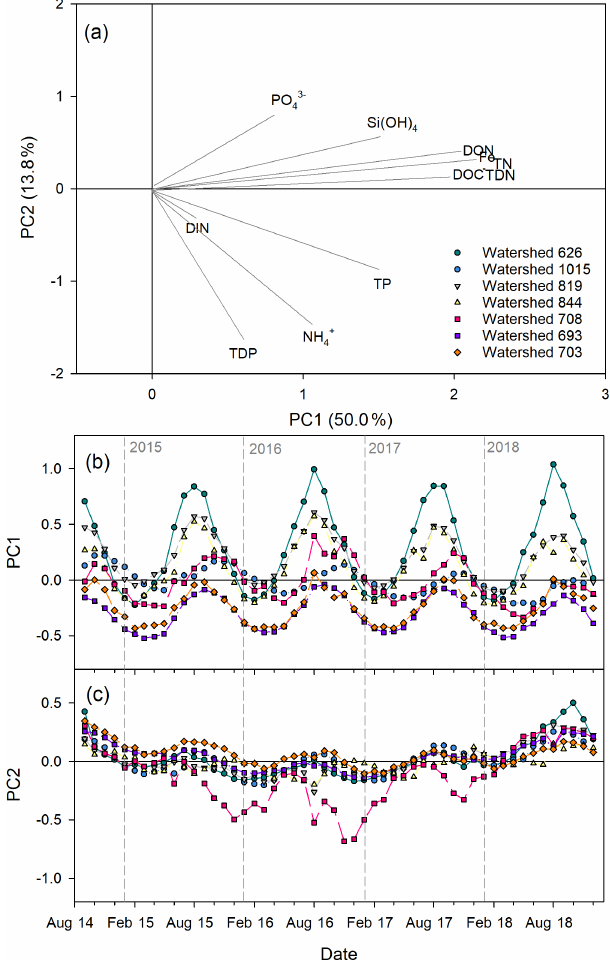
Figure 5. Principal component analysis of flow-weighted bulk freshwater chemistry exports to the nearshore environment. (a) Nu- trients in principal component (PC) space (scaled to preserve cor- relation between variables). Changes in PC1 (b) and PC2 (c) over time (scaled to preserve distance between objects). Note that PC1 loadings were multiplied by − 1 to facilitate